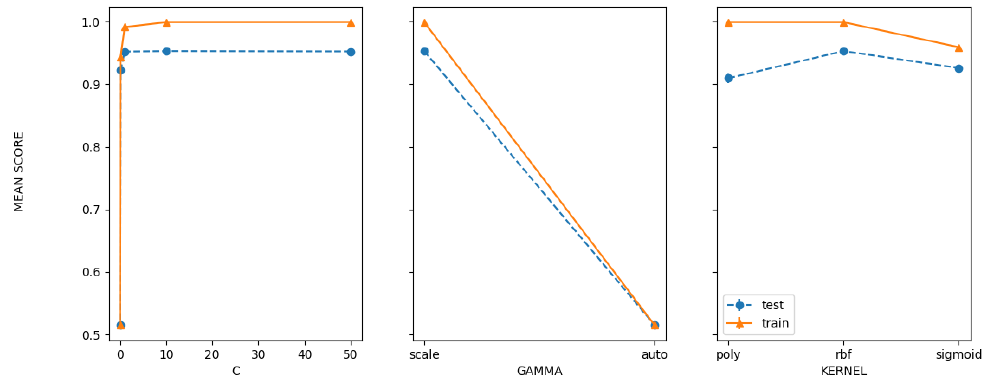
Figure 16. Score per parameter for Support Vector Classifier (SVC). Table 6. Hyperparameter tuning for Logistic